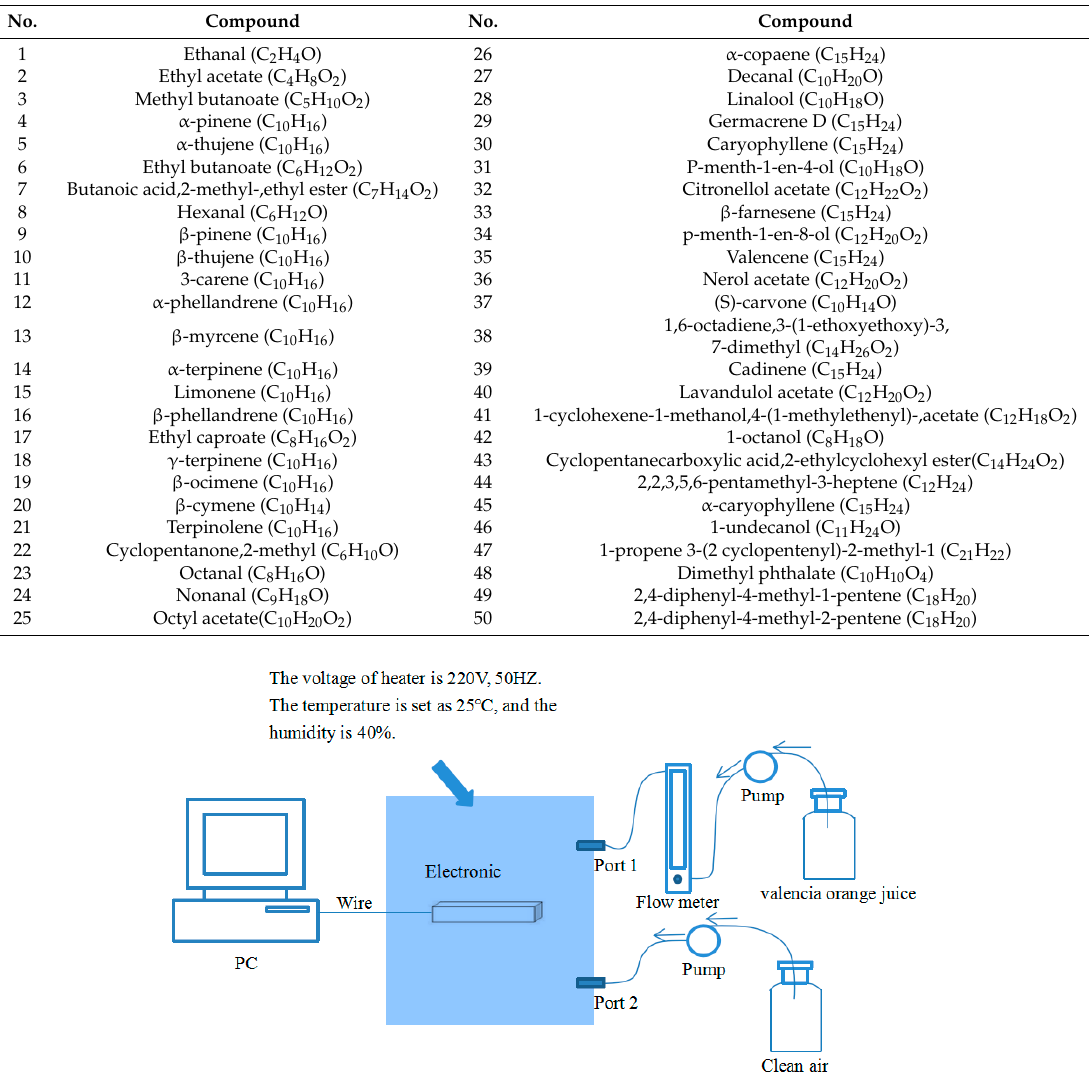
Figure 2. A schematic diagram of the experimental system.